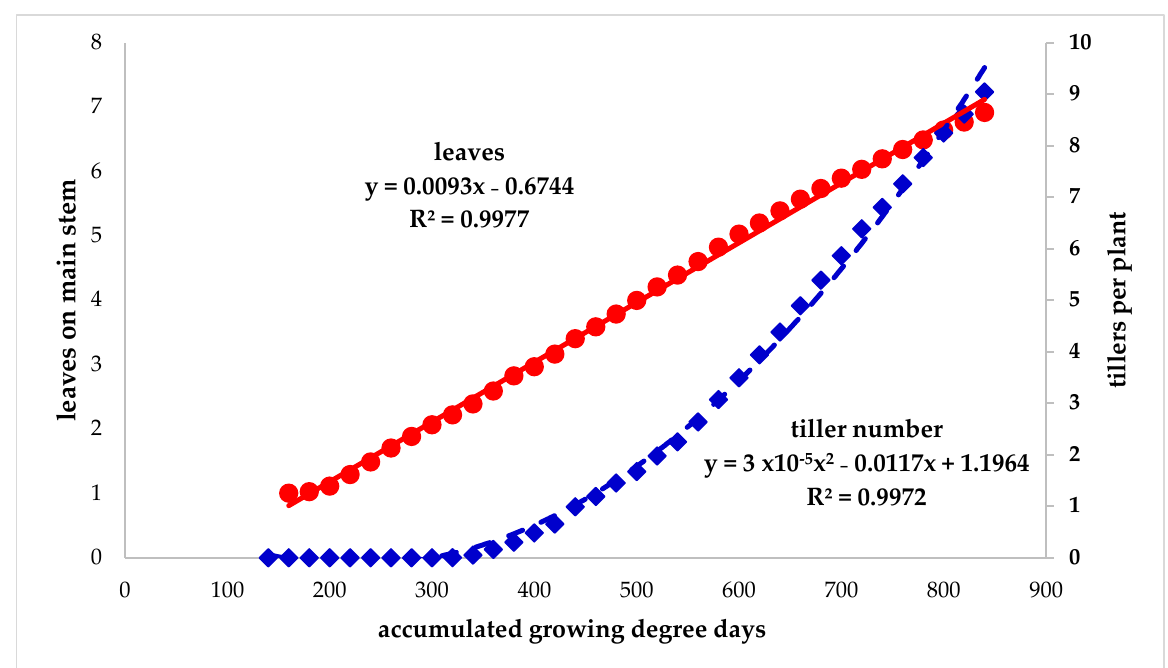
Figure 2. Regression of accumulated growing degree days (x) for mean daily leaves on the main stem (primary y axis) (red circles) and mean daily tillers plant −1 (secondary y axis) (blue squares).